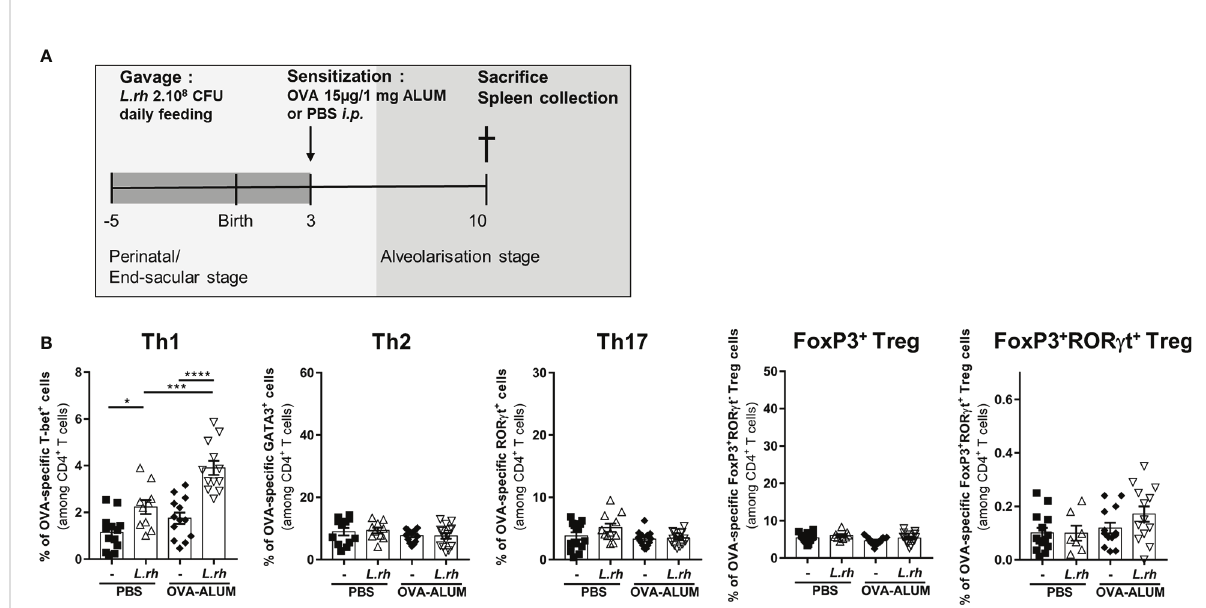
FIGURE 3 Maternal L.rhamnosus treatment promotes a Th1 polarization in the neonatal spleen. (A) Neonates born from control (-) or probiotic- supplemented mother ( L.rh ) were sensitized on PND3 with 15µg OVA in 1mg ALUM and sacri fi ced 1 week later. (B) Percentages of OVA-speci fi c CD4 + T cells expressing the transcription factors associated to Th1 (T-bet), Th2 (GATA3), Th17 (Ror g T), conventional Treg (FoxP3) and ROR g t Treg (FoxP3 and ROR g t) were determined by FACS in the spleen on PND10. Results are a pool of 4 independent experiments and are shown as mean ± SEM. Statistical analysis was done using an ordinary one-way ANOVA test (Holm-Sidak ’ s multiple comparisons test) or a Kruskal-Wallis test (Dunn ’ s multiple comparisons test) (* = p<0.05; *** = p<0.001;, **** = p